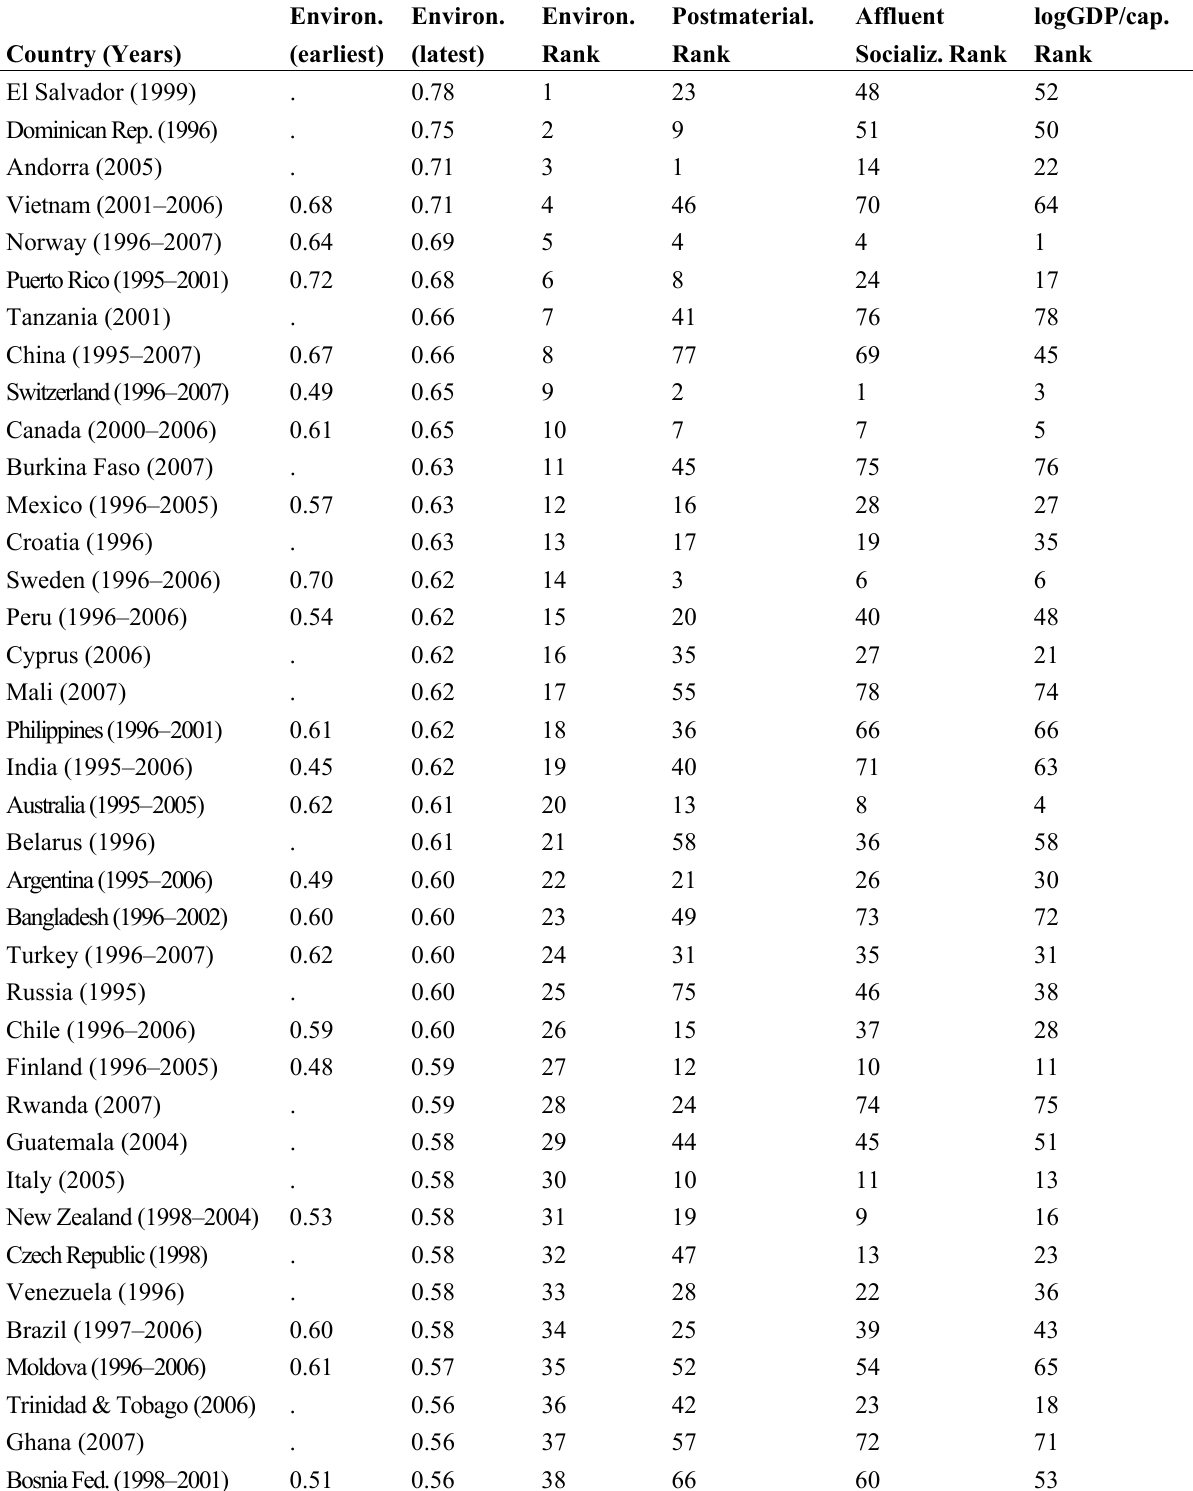
Table 1. Countries ranked by environmentalism, postmaterialism and